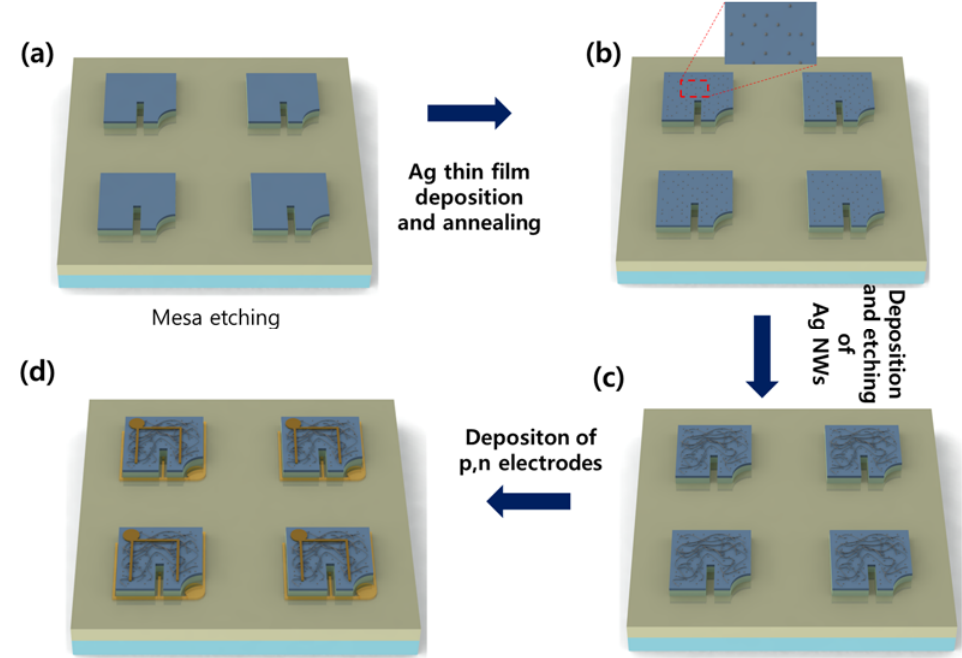
Figure 1. Schematic illustrations and images corresponding to steps for the fabrication of GaN LEDs with Ag-NW/NP-based TCE. ( a ) To fabricate LEDs 500 × 500 µm 2 in size, the p-GaN and MQWs were sequentially etched using inductively coupled plasma with boron trichloride gas until n-contact layer was exposed. ( b ) Ag films with thicknesses of 1 nm were selectively deposited by e-beam evaporation on the p-GaN and annealed at 500 °C for 1 min in nitrogen ambient to form Ag NPs. ( c ) Ag NWs were chemically synthesized according to a previously reported method [19], dispersed in deionized water, and deposited by spin-coating method to obtain a flat film. After photolithography to form TCE region, the Ag NWs were etched using a dilute diluted nitric acid solution of HNO 3 /H 2 O (10:1). For a comparative study, a Ag NW layer without NPs was deposited. To form an Ohmic contact, the coated Ag NW layers were annealed at 150 °C for 10 min in nitrogen ambient. ( d ) Cr/Au was deposited on TCE and n-GaN by e-beam evaporation to obtain n- and p-pads.